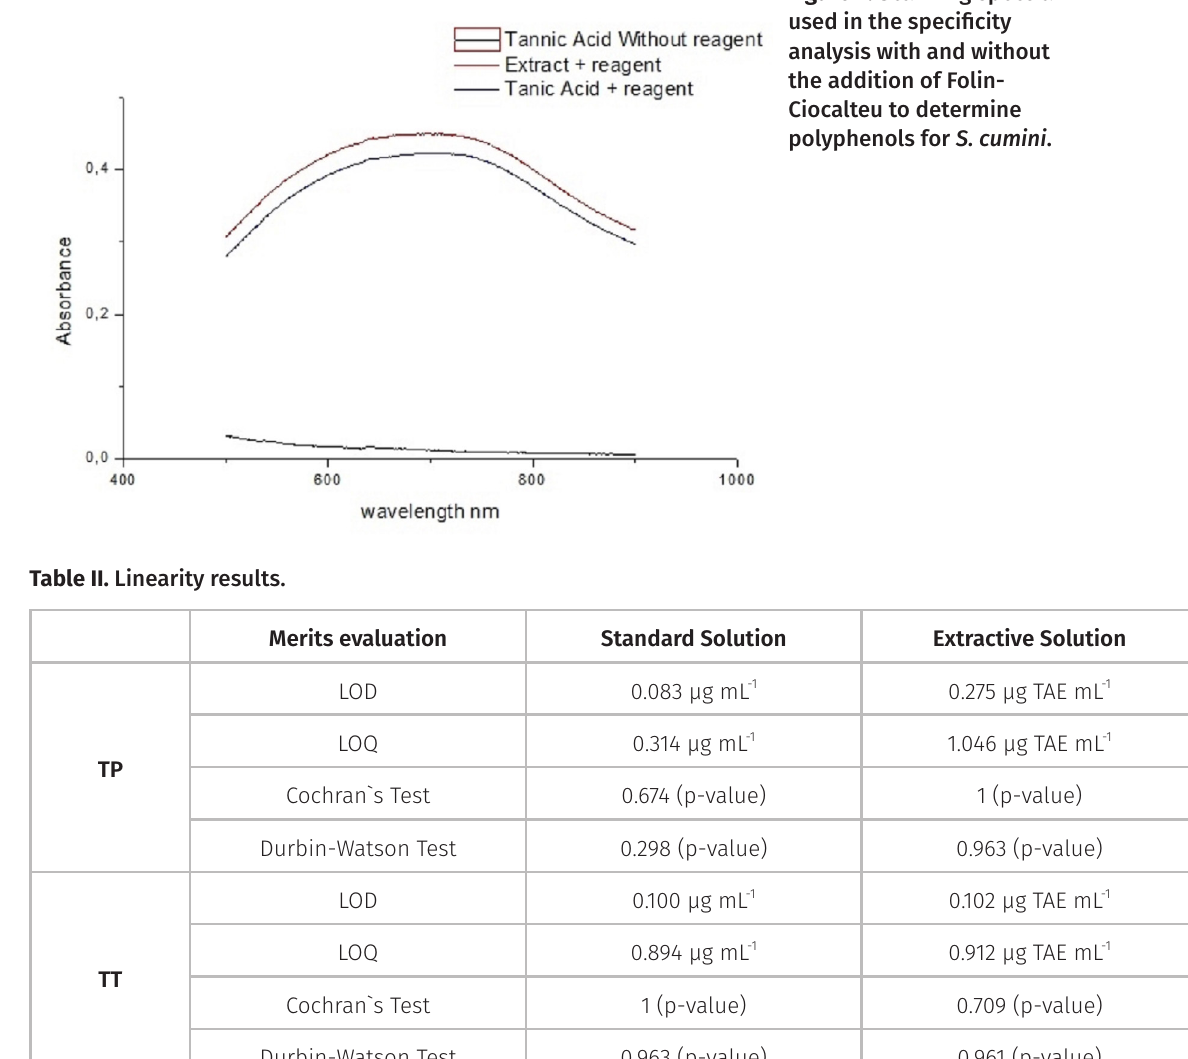
Figure 2. Scanning spectra used in the specificity analysis with and without the addition of Folin- Ciocalteu to determine polyphenols for S. cumini